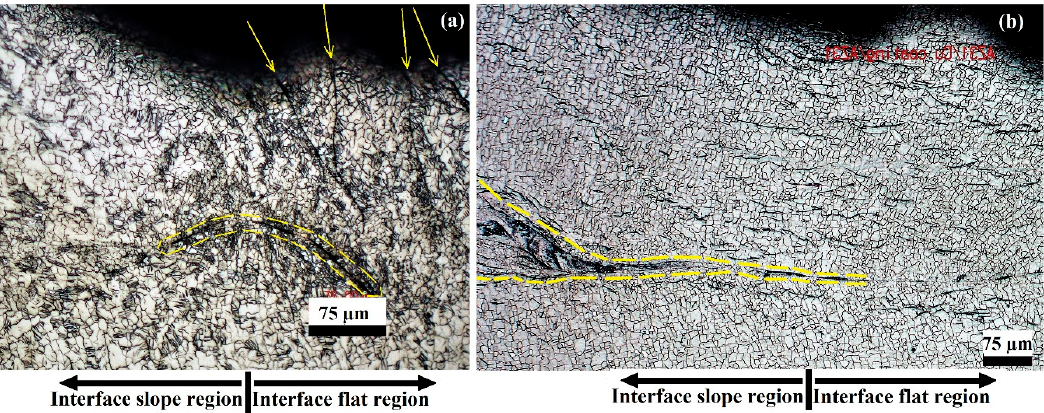
Figure 6. Comparison between macrographs of joint type A and B in transition region from flat part to slope part of the interface; ( a ) Joint type A (1400 J); ( b ) joint type B (1100 J).